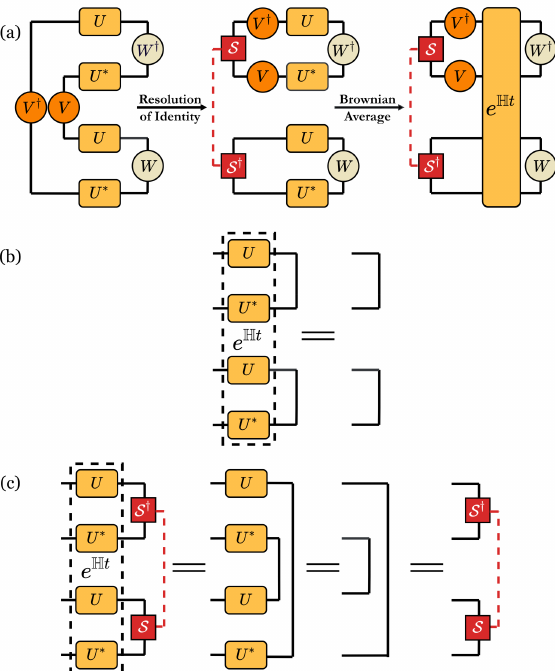
Figure 1 . (a) Resolution of the identity in the OTOC, followed by the Brownian average. (b) The invariance of the Identity operator-state | I ⊗ I i under the effective imaginary-time evolution. (c) The invariance of the complete set of operator-states P |S † ⊗ Si under the effective imaginary- S time evolution. Both operator-states considered in (b) and (c) remain eigenstates of the effective Hamiltonian H because they are invariants of the circuit even before the random